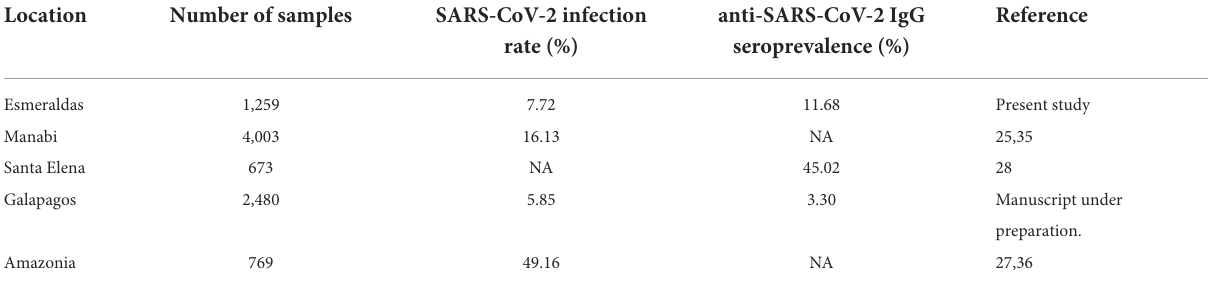
TABLE 3 Comparison of SARS-CoV-2 infection rate by RT-qPCR and anti-SARS-CoV-2 Ig seroprevalence for surveillance studies performed in Ecuador during the COVID-19 pandemics (NA: Not available). Location Number of